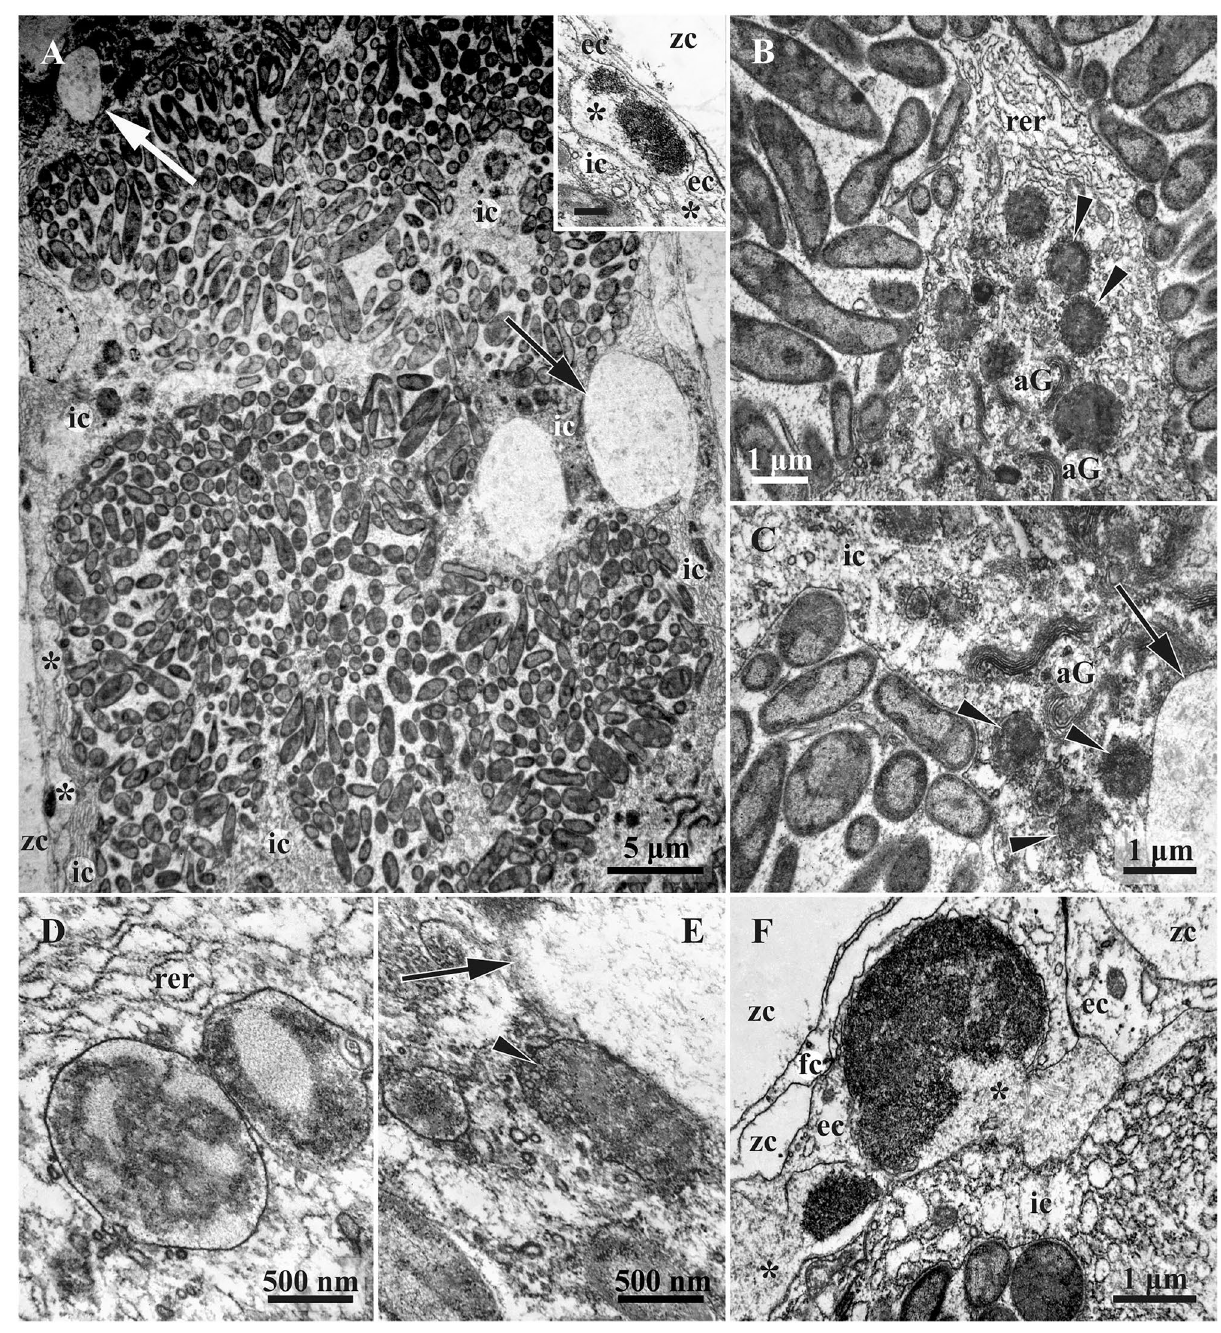
Figure 7. Ultrastructure of funicular bodies of Dendrobeania fruticosa (collected on 23 June 2018) showing the initial stage of degradation (TEM). ( A ) Part of FB densely filled with modified bacteria; large expanded parts of RER shown by arrows (also visible in C and E ) (inset: peripheral area of FB wall showing cells of both external and inner layers and forming ‘interlayer’ space (asterisks) containing electron-dense bodies; scale bar 500 nm). ( B , C ) Bacteria and cells of inner layer with presumed phagosomes (arrowheads) containing bacteria-like content. ( D , E ) Presumed phagosomes (shown by arrowhead in E ) with bacteria-like content shown at higher magnification. ( F ) Peripheral area of FB wall showing cells of external and inner layers with an interlayer space (ILS) (asterisks) between them containing electron-dense bodies and ‘fibrils’ sometimes in groups (also visible in inset). aG Golgi apparatus, ec cells of external layer, fc funicular cell, ic cells of inner layer, rer rough endoplasmic reticulum, zc zooidal